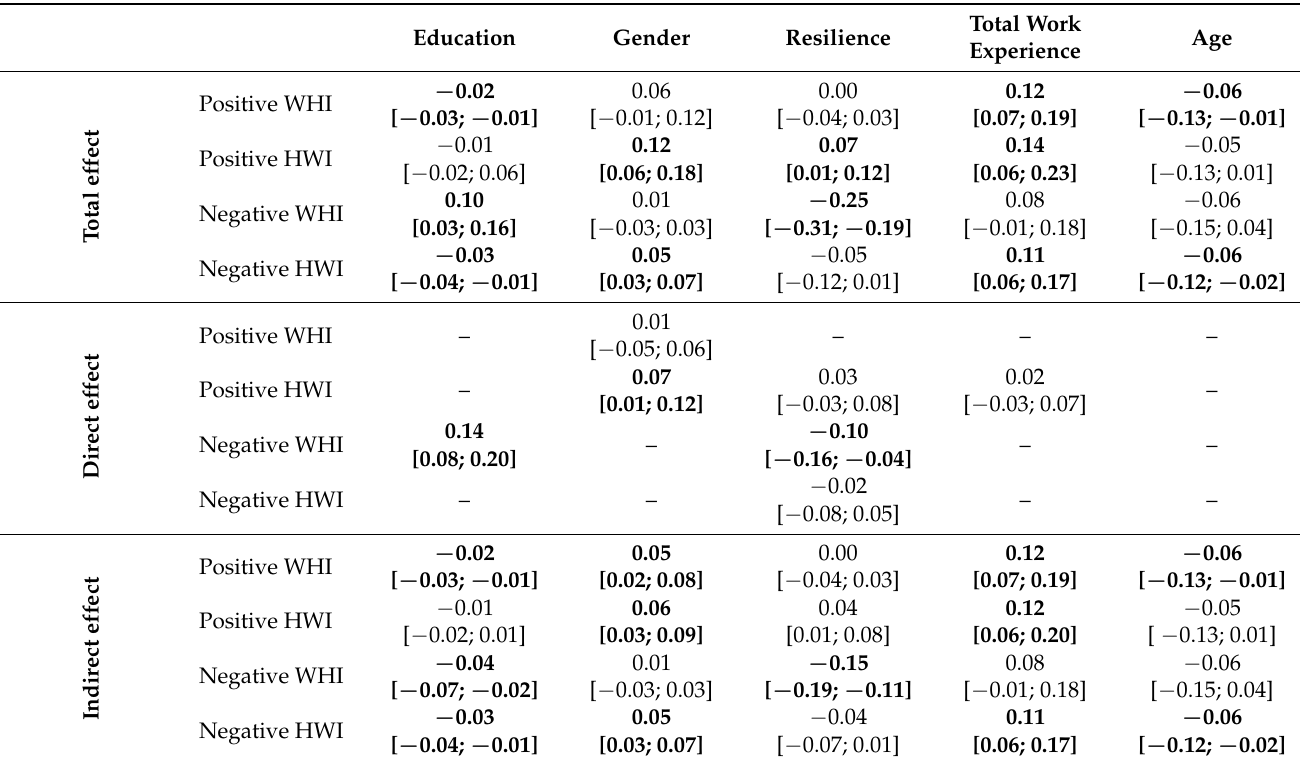
Table 6. Summary of total, direct, and indirect effects in the explanatory model of the home–work and work–home relationships—standardized regression coefficients with a 95%